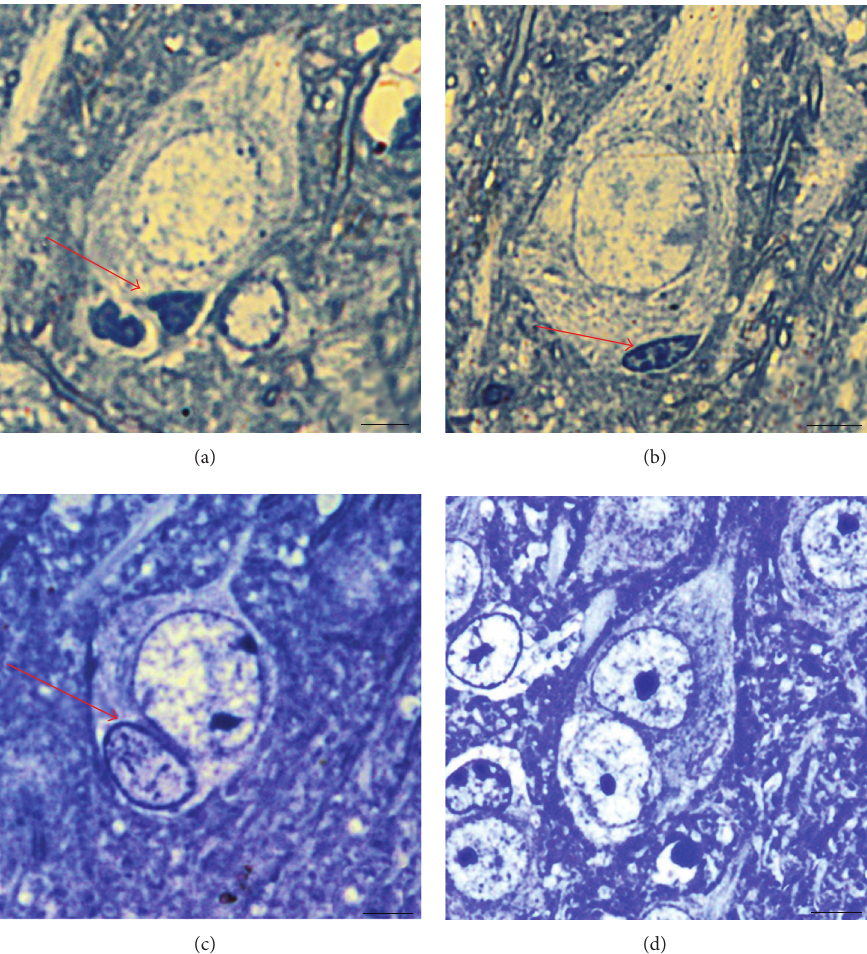
Figure 8: Changes in the structure of the chromatin and the size of the oligodendrocytic nucleus after fusion with a neuron. (a) The oligodendrocytic nucleus is indicated with an arrow. It is located in the neuron’s cytoplasm. The nucleus has not changed yet; it is still small, and the chromatin structure cannot be revealed. (b) Beginning of the reprogramming. The size of the nucleus (arrow) did not change, but the chromatindividedintodarkheterochromatinandpaleeuchromatininthecenterofthenucleus.(c)Theoligodendrocyte’snucleus(arrow)size increased significantly. The heterochromatin belt along the nuclear membrane is wider than that of the neuron’s nucleus. (d) Reprogramming completion. The heterokaryon has completely been transformed into a cell that has two identical nuclei—a dikaryon. Semi-thin sections. The scale bar is 10 𝜇